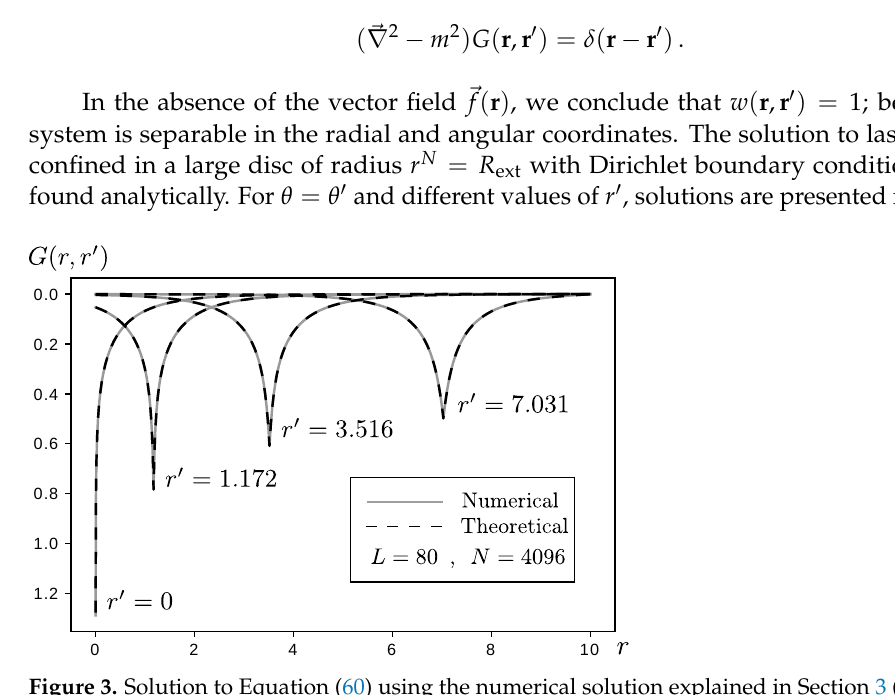
Figure 3. Solution to Equation (60) using the numerical solution explained in Section 3 (continuous gray lines) and using Equation (62) (black dashed lines) for θ = θ (cid:48) and different values of r (cid:48) . We have chosen in all cases units such that m = 1. We also used L = 80 for both cases. In the numerical solutions N = 4096 and (cid:101) = 0.25 h , in the analytical solution s = 0.15 h . The values of the minima and the mean square error (MSE) are shown in Table